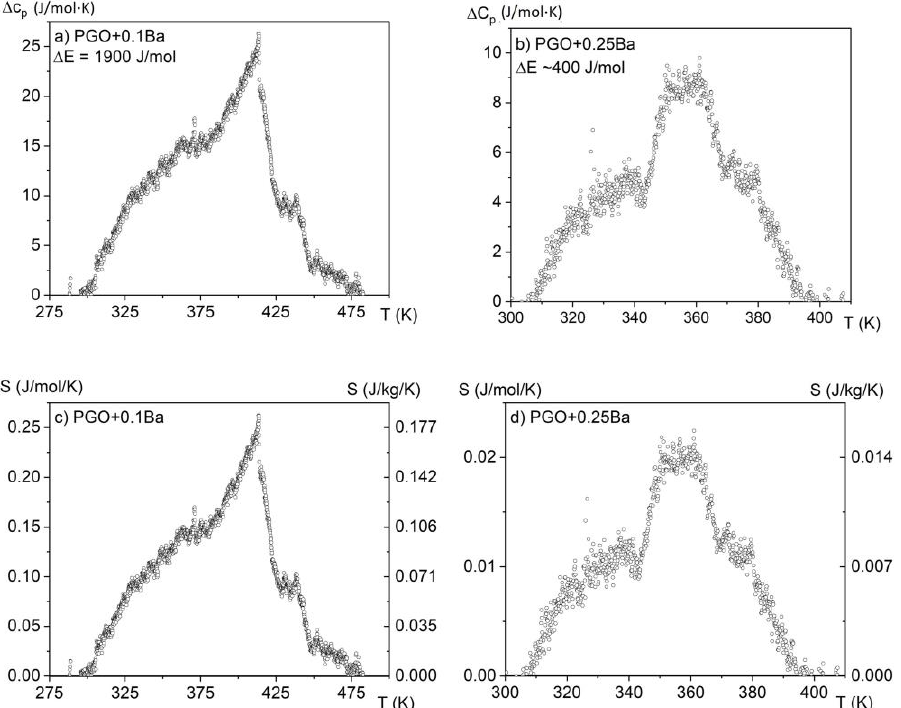
Figure 5. Excess specific heat and estimated values of latent heat ( a , b ) and entropy change ( c , d ) for two samples: PGO + 0.1Ba and PGO + 0.25Ba.